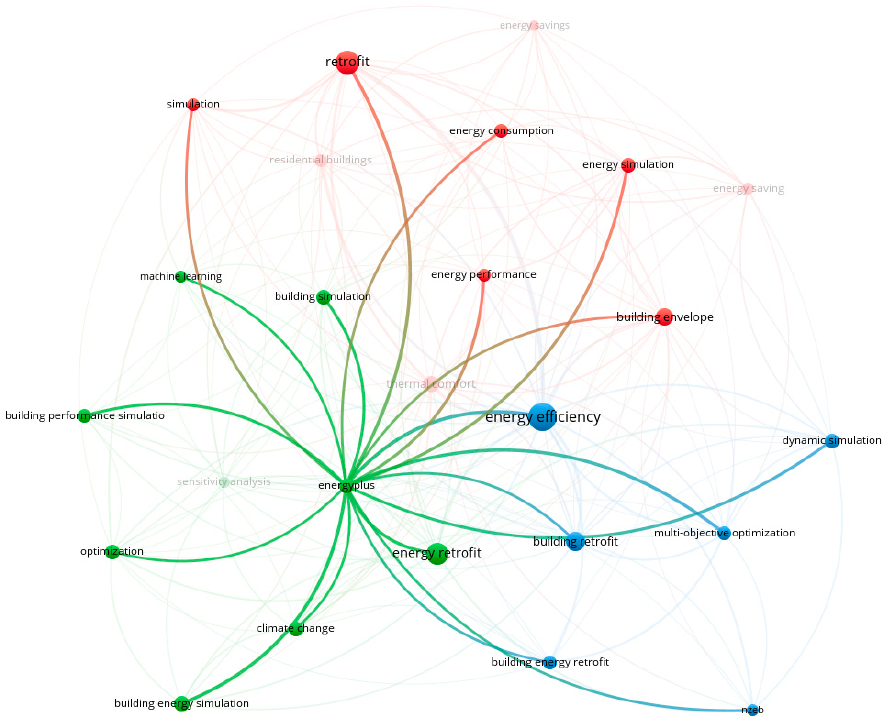
Figure 8. Articles related to building energy simulation in building envelope retrofit projects and their relationship with EnergyPlus.